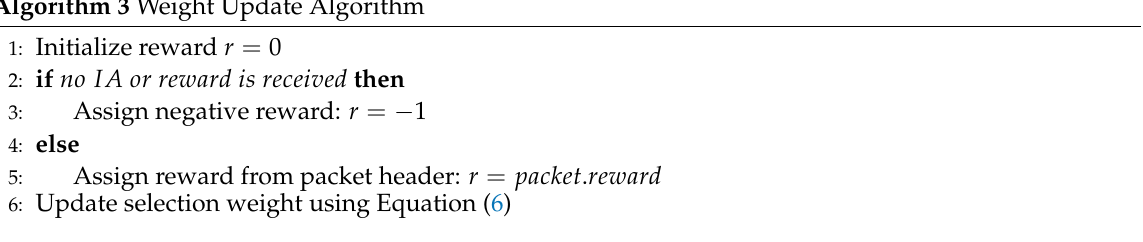
Algorithm 3 Weight Update